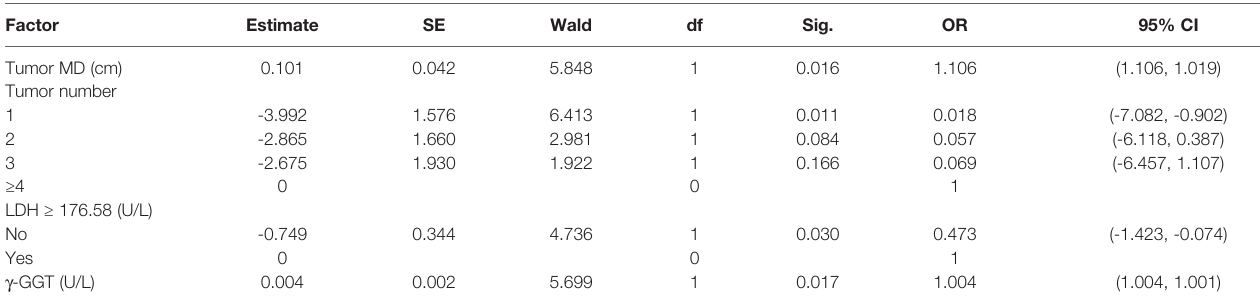
TABLE 4 | Multivariable analysis of predictors associated with